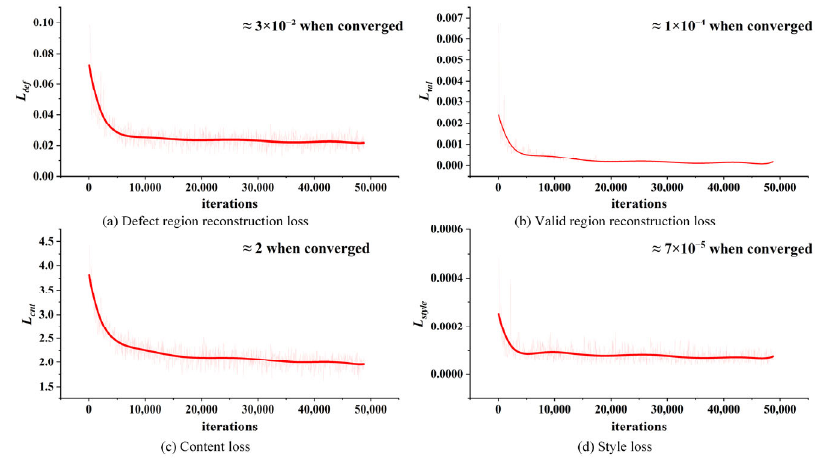
Figure 9. Loss function curves when converge. ( a ) The reconstruction loss curve of the defects re ‐ gion. ( b ) The reconstruction loss curve of the valid region. ( c ) The content loss curve. ( d ) The style loss curve.